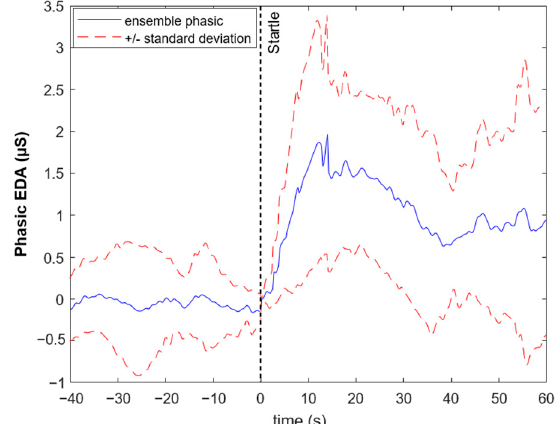
Figure 6. Ensemble of the phasic component for the Startle test from 40 s before the onset of the startle stimulus (umbrella) until 60 s after the stimulus.